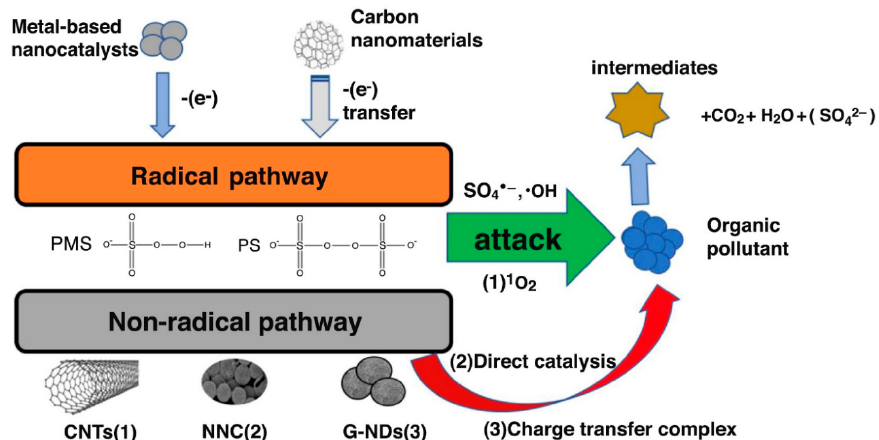
Figure 8. Mechanism of persulfate activation by metal-based catalysts and carbonaceous materials. Reproduced with permission from Xiao, et al. [128]. Copyright (2018) Elsevier.